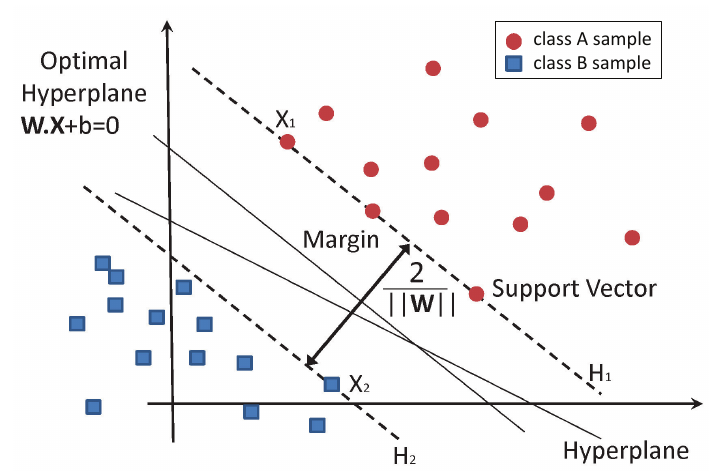
Figure 2. Classification of data by support vector machine